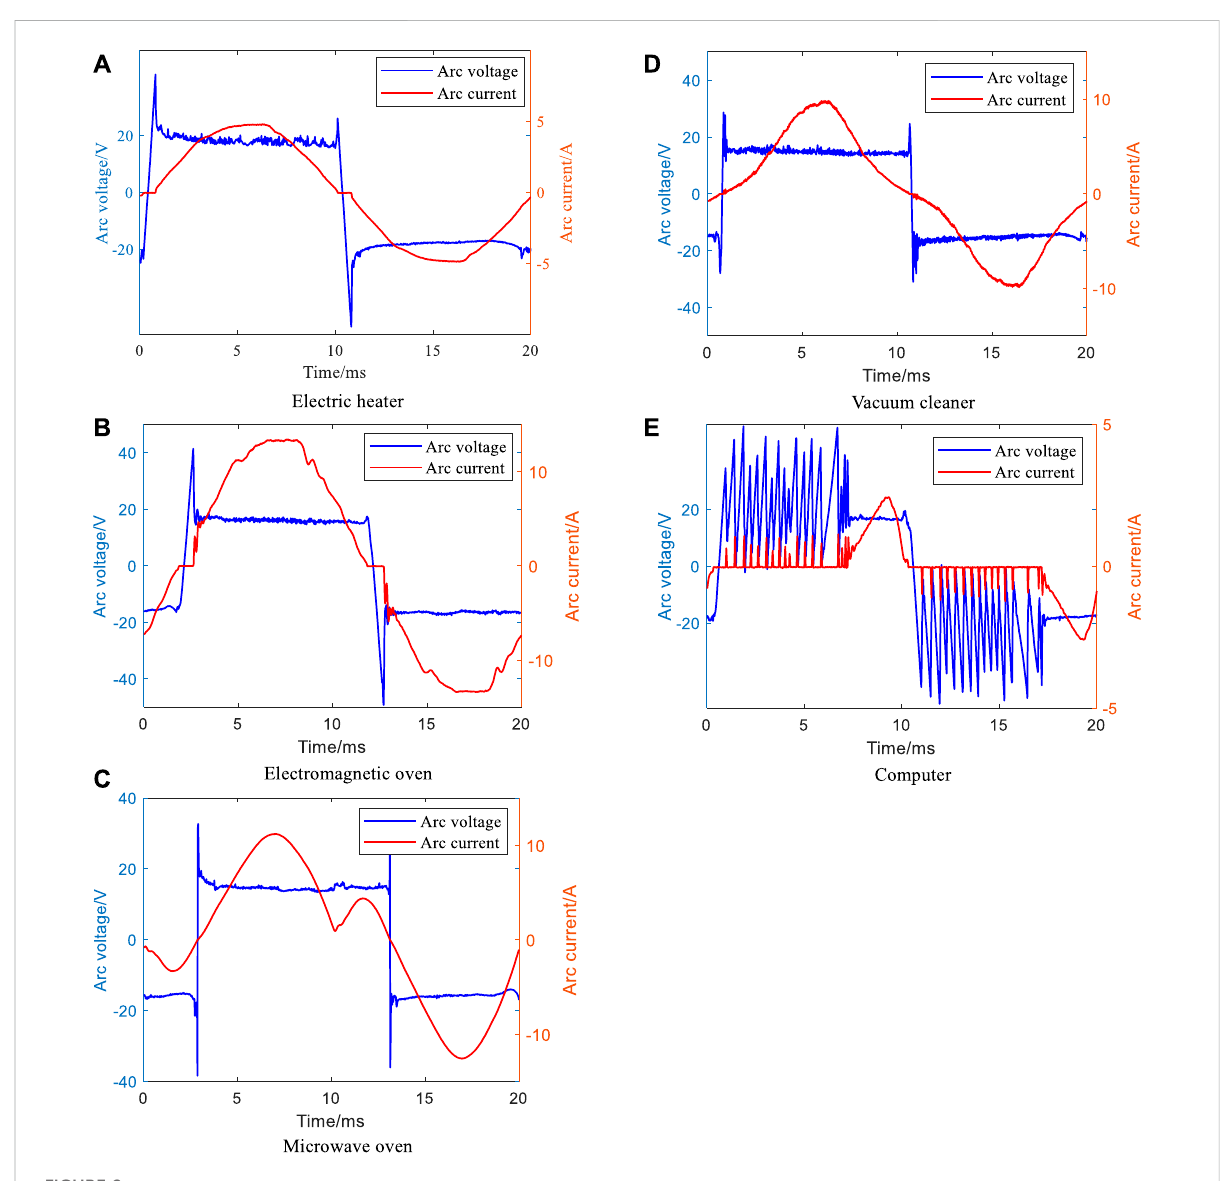
FIGURE 2 Waveforms of arc voltage and current of different types of loads (A) Electric heater (B) Electromagnetic oven (C) Microwave oven (D) Vacuum cleaner (E)